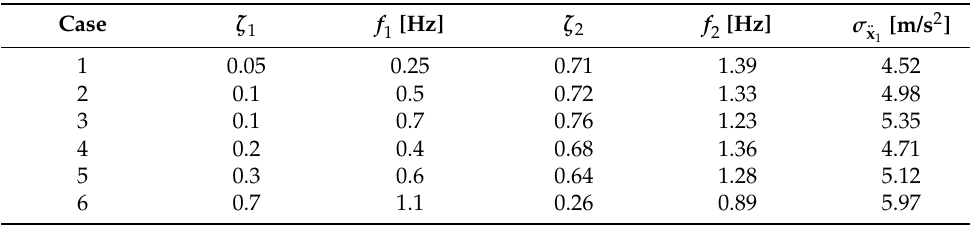
Table 3. The transmissibility factors of asymmetric PWL